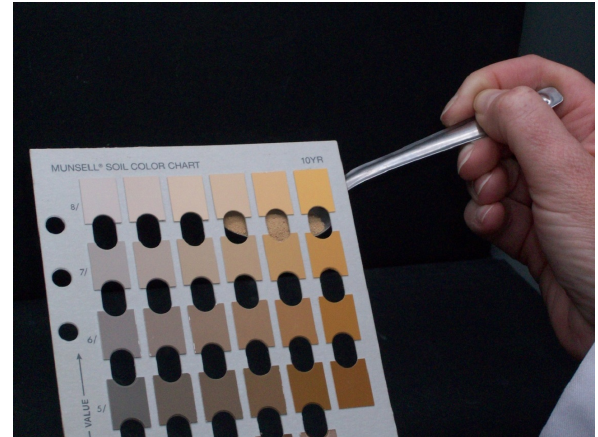
Figure 2: Visual assessment of soil colours with Munsell charts The USDA published the colour charts in collaboration with the Munsell Color Company where a team of arstists and scientists leaded by A.F. Munsell developed a physical implementation of a colour solid. The colour solid was supposed to represent the whole domain of colours that were physically realizable with the colour technology